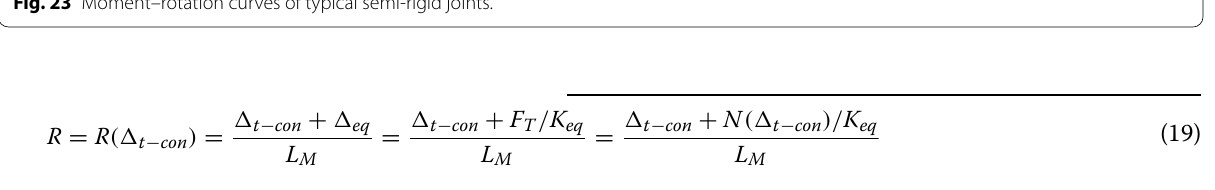
Fig. 23 Moment–rotation curves of typical semi‑rigid